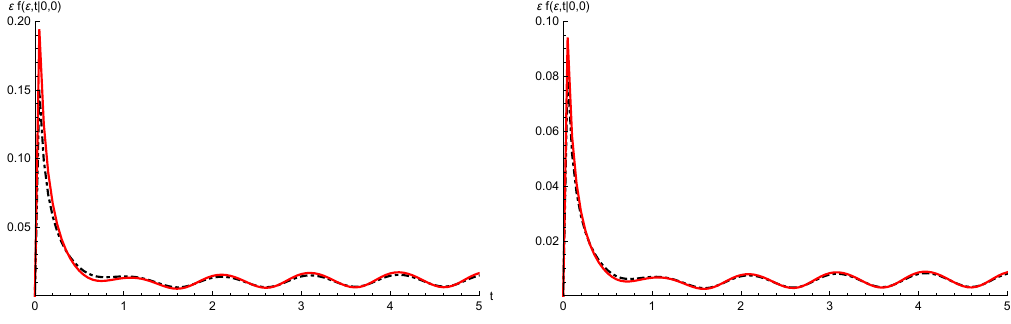
Figure 8. For the same choices of parameters of Figure 6, the function ε f ( ε , t | 0,0 ) (red curve) is compared with the probability p 0,1 ( t | 0 ) (black dashed curve) for ε = 0.05 (left) and ε = 0.025